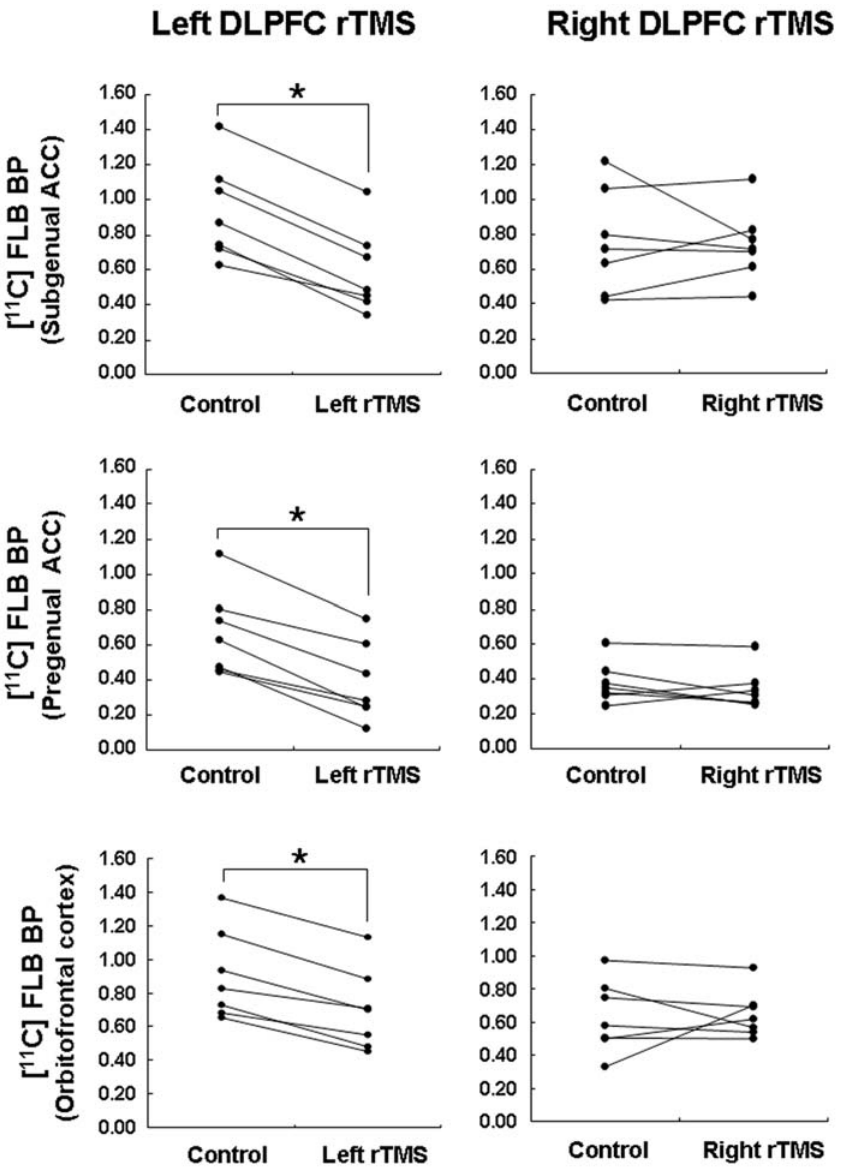
Figure 2. Individual mean BPs extracted from 10 mm radius VOI. Upper, middle and lower figures show the individual [ 11 C]FLB 457 BP changes the subgenual ACC (x= 2 10, y=28, z= 2 18), pregenual ACC (x= 2 14, y=40, z= 2 10) and medial orbitofrontal cortex (x= 2 6, y=30, z= 2 20) under control and active rTMS conditions, respectively. doi:10.1371/journal.pone.0006725.g002 PLoS ONE |